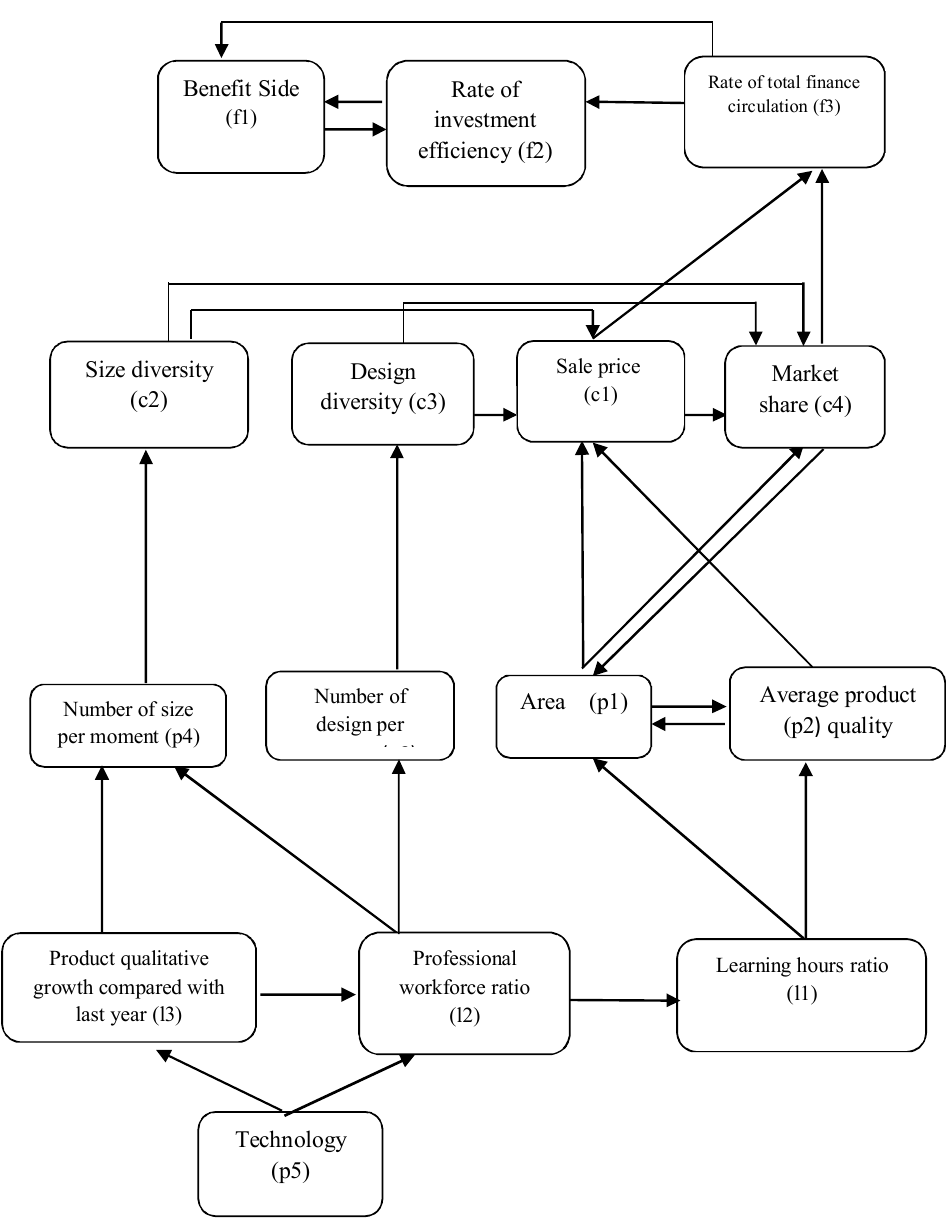
Fig. 3. Strategy plan of tile and ceramic industry in four perspectives of BSC